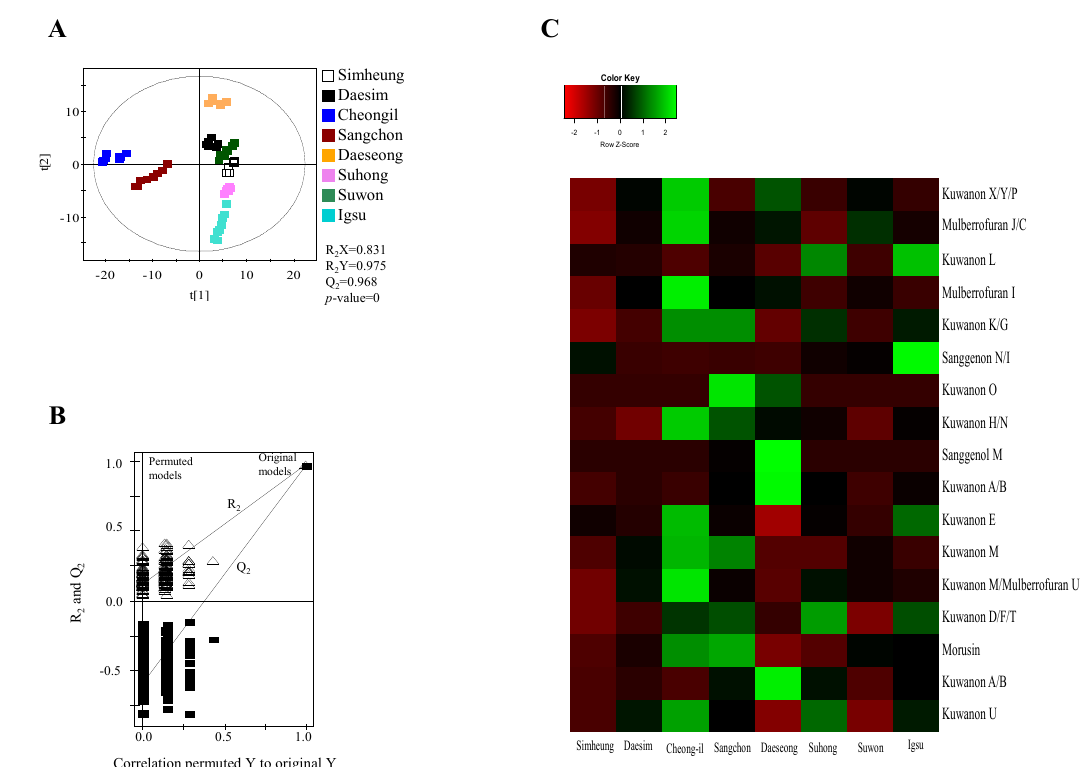
Figure 2. Partial least squares discriminant analysis (PLS-DA) scores ( A ), their quality parameters ( B ), and heat map ( C ) for ESI-negative mode from Morus roots with di ff erent cultivars ( Simheung , Daesim , Cheong-il , Sangchon , Daeseong , Suhong , Suwon , and Igsu ). The quality of the PLS-DA score plots was evaluated by R 2 X, R 2 Y, Q 2 , and p -values ( A ) and validated by permutation tests ( B ). The heat map was drawn by R with ggplot2, and the green–red color represents the z -score transformed raw data of Morus root metabolites with significant di ff erences among sample groups. Red and green colors indicate a decrease and an increase in metabolite level,